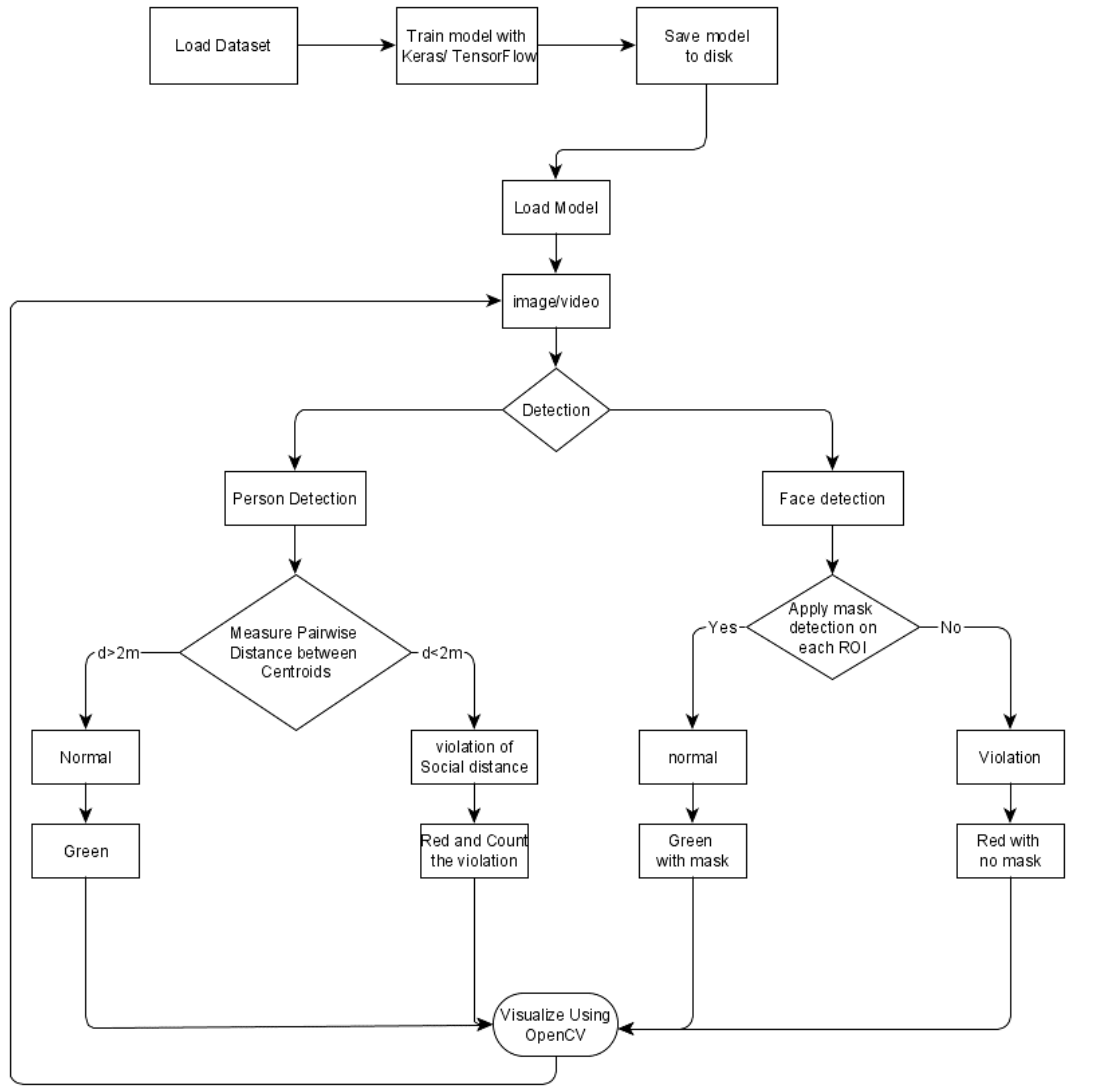
Figure 1. The proposed approach's model state